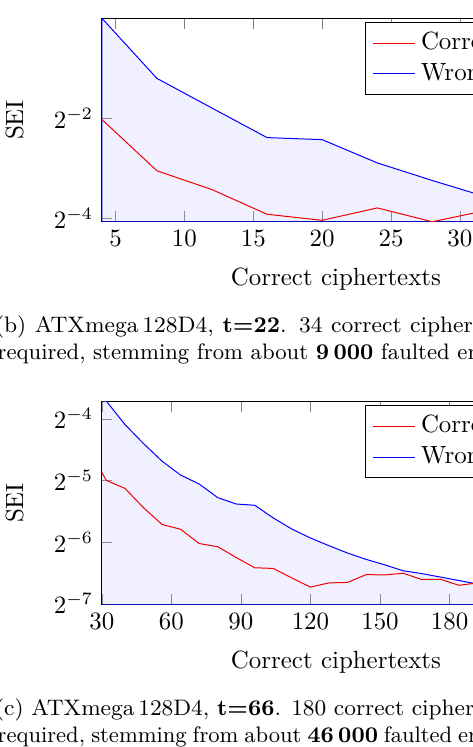
Figure 7: Attacks on infective countermeasure. SEI of the correct key (SEI R ) vs. best SEI of a wrong key (SEI ∗ ) for N correct W